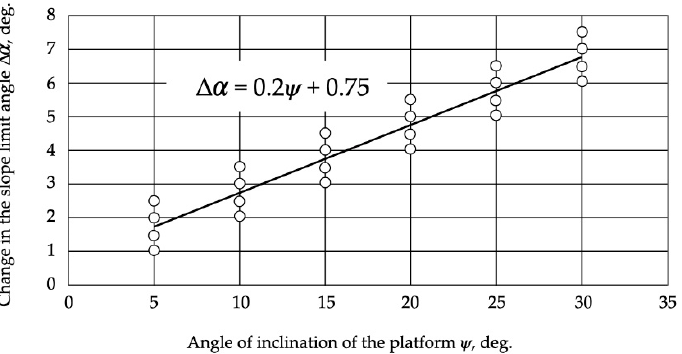
Figure 5. Calculation scheme of center of mass displacement when the feller buncher is tilting.